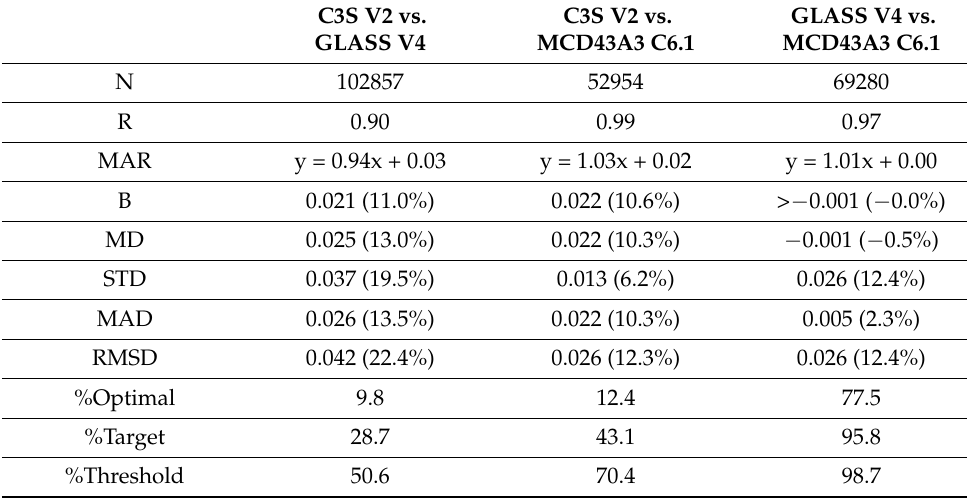
Table 11. Summary of the main statistics for scatterplots between C3S V2 vs. GLASS V4, C3S V2